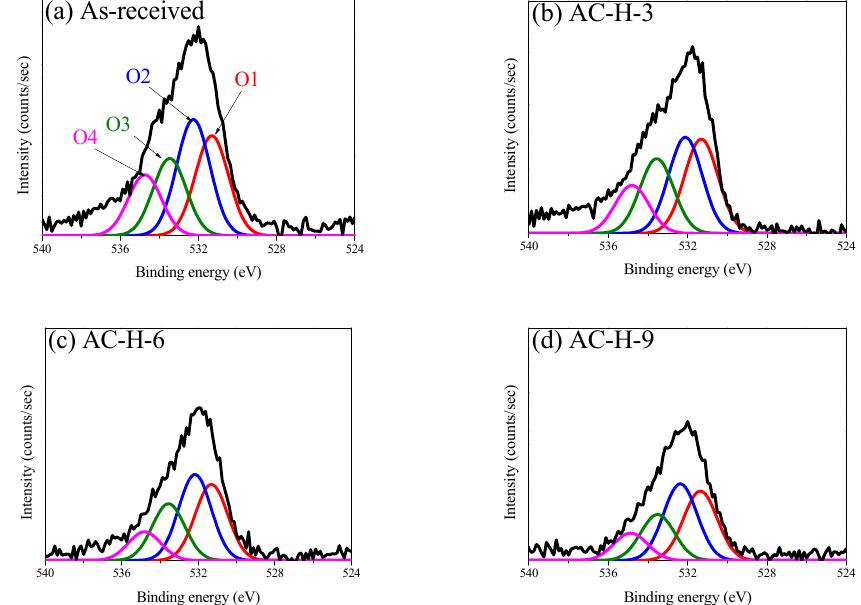
Figure 4. High ‐ resolution O 1S spectra of AC ‐ H; ( a ) As ‐ received, ( b ) AC ‐ H ‐ 3, ( c ) AC ‐ H ‐ 6, ( d ) AC ‐ H ‐ 9.